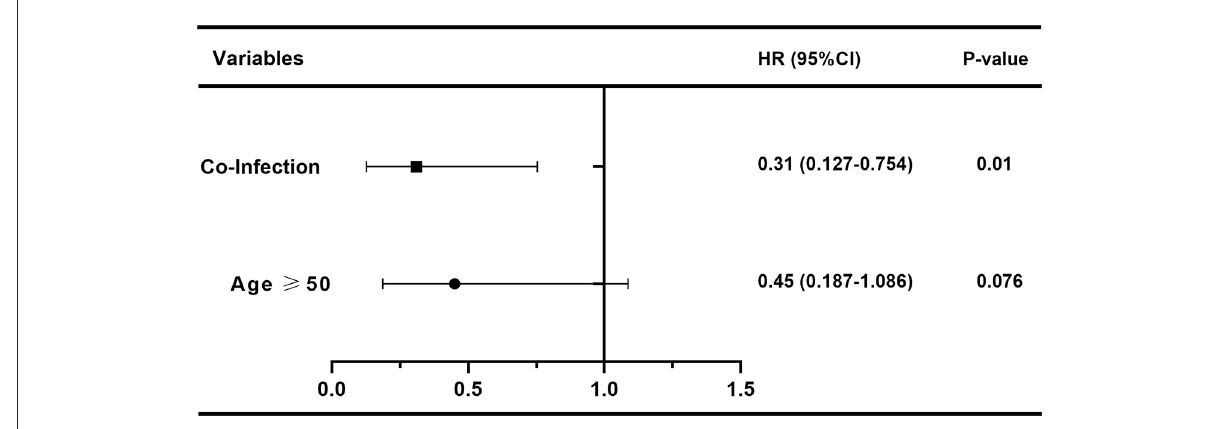
FIGURE4 Forest plot of multivariate logistic regression analysis results.